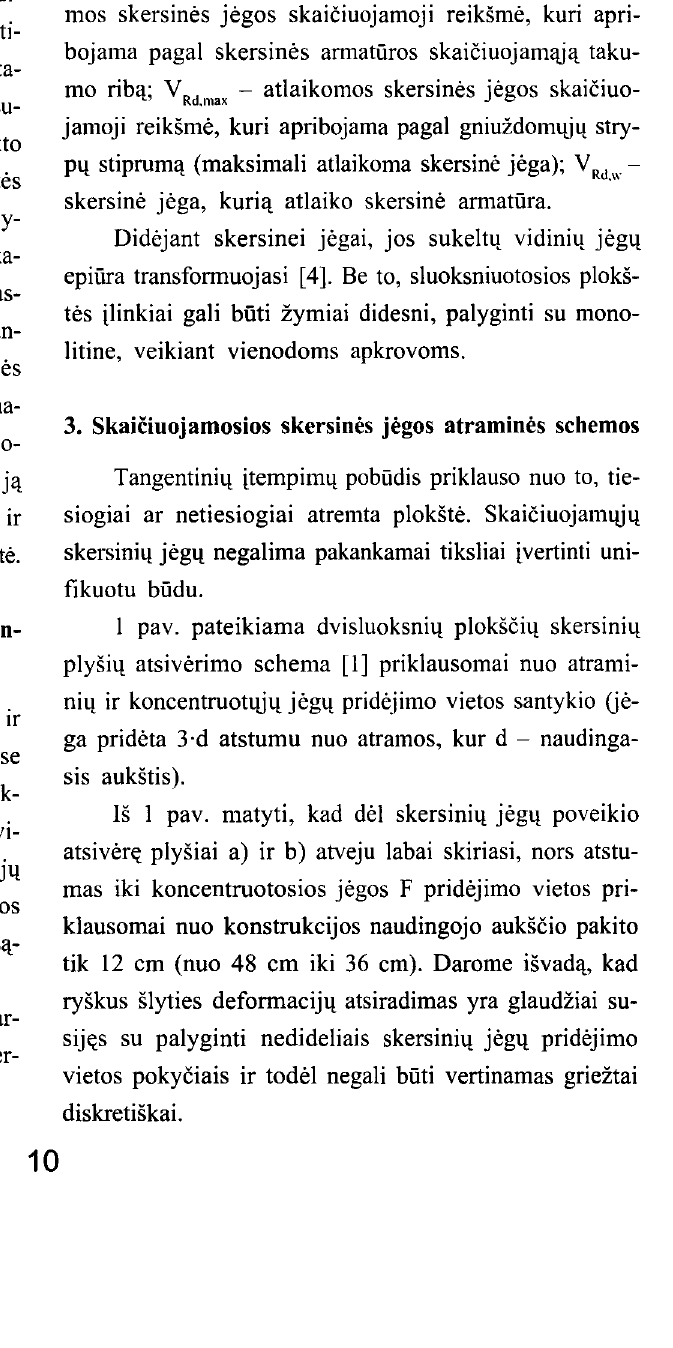
- j eigu V Sd :2: V Rd.c - skersine armatiira parenkama taip, kad atitiktq S~tlyg<t V sd.w ::;; V Rd.y; - jeigu Vsd :2: V Rd.max - s~tlyga neleidziama, reikia